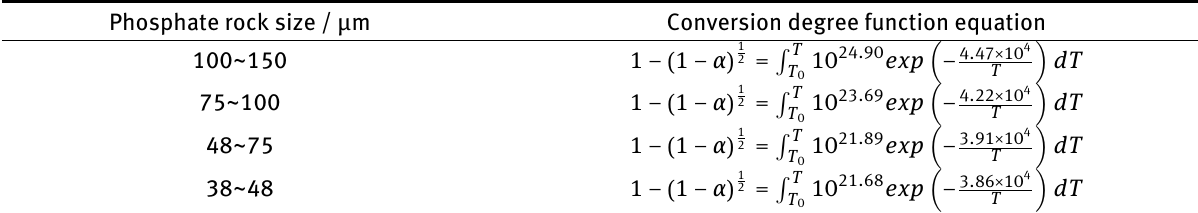
Table 6: Kinetic equations of carbothermal reduction process of phosphate rock with different particle sizes Phosphate rock size / µ